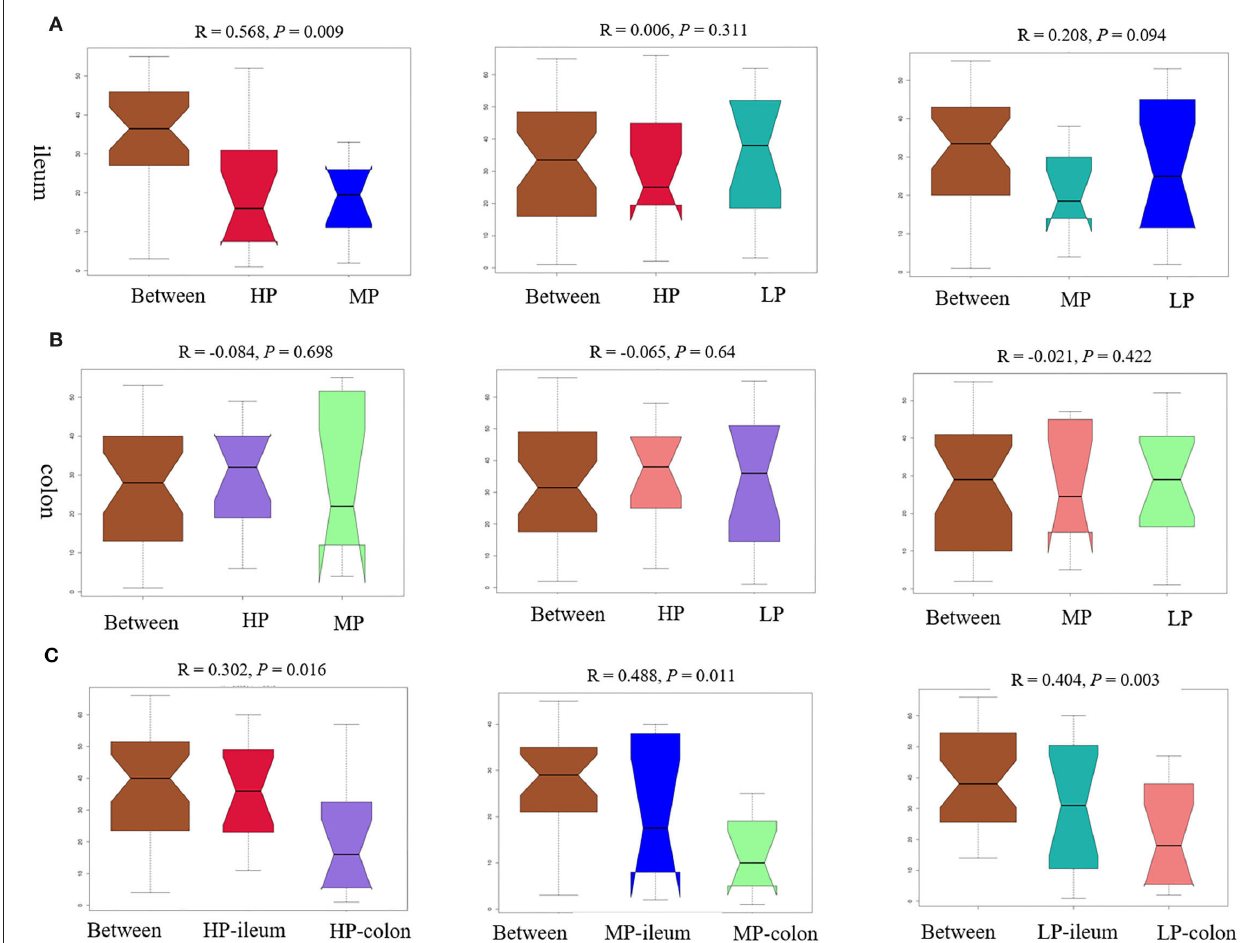
FIGURE 5 | The analysis of similarities (ANOSIM) tests of gut microbiota. The ANOSIM tests were performed between groups based on relative abundance of OTU. ANOSIM results for ileal (A) and colonic (B) microbiota structure, as well as for the comparison between ileum and colon (C) from either HP, MP, or LP group. HP, high protein (16% crude protein); MP, medium protein (12% crude protein); LP, low protein (10% crude